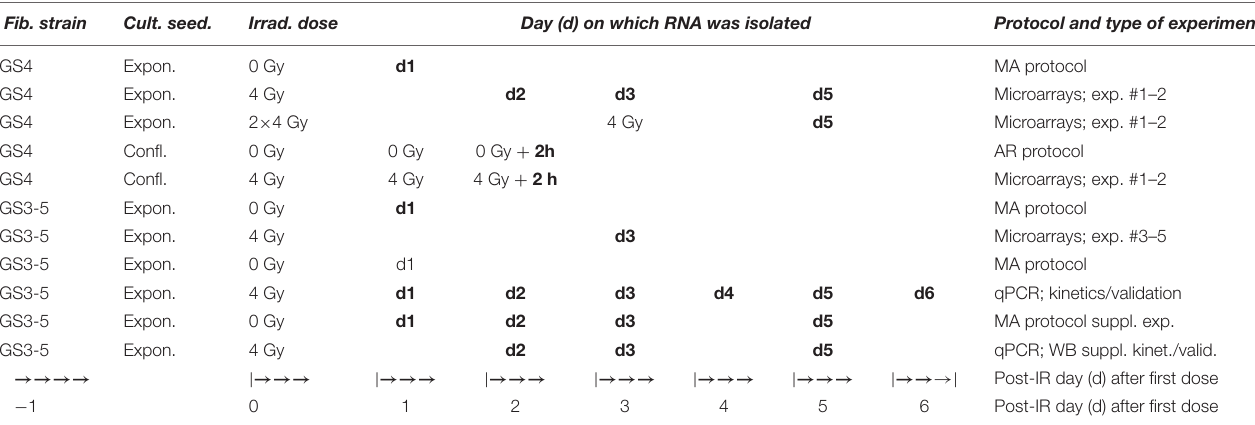
TABLE 1 | Experimental design of microarray and qPCR experiments. Fib.